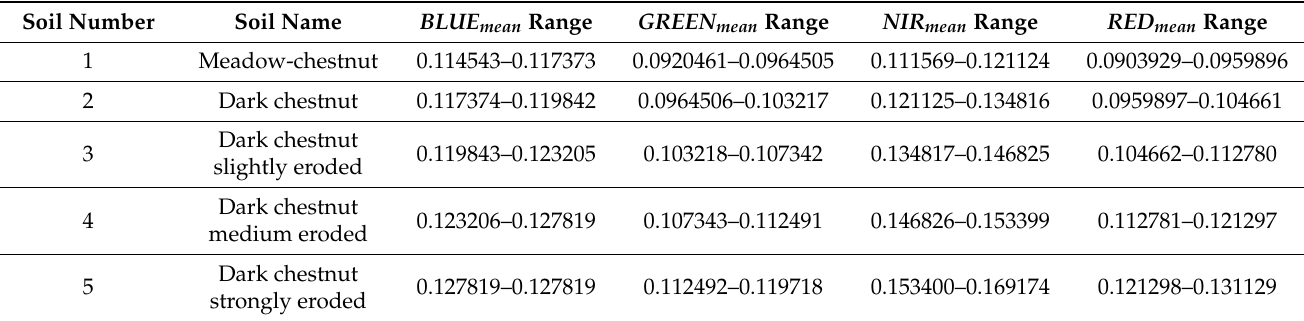
Table 2. Classification of ranges of the Landsat bands mean values according to soil